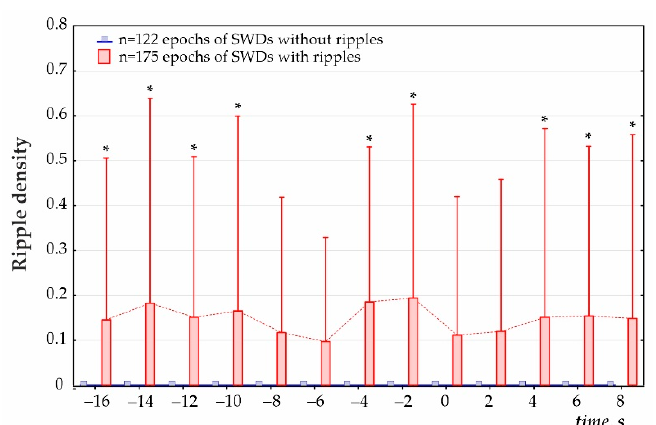
Figure 5. Dynamics of ripple density before and during SWDs. The onset of SWDs is zero time. *—significant differences between the SWD-containing epochs with ripples ( n = 175) and SWDs without ripples ( n = 122), Bonferroni test, p < 0.05.